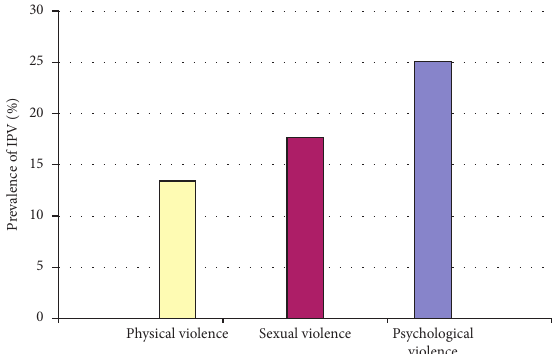
Figure 2: Magnitude of three forms of intimate partner violence among pregnant women attending antenatal care services at public health facilities in Ofla District, Tigray, Ethiopia, 2019 ( N �